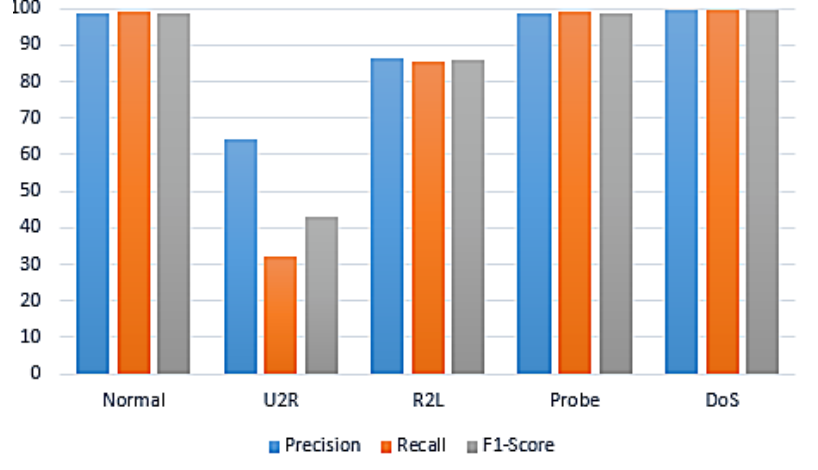
Figure 14. Logistic regression classification report. Table 3. Average training and testing accuracies of the proposed models.